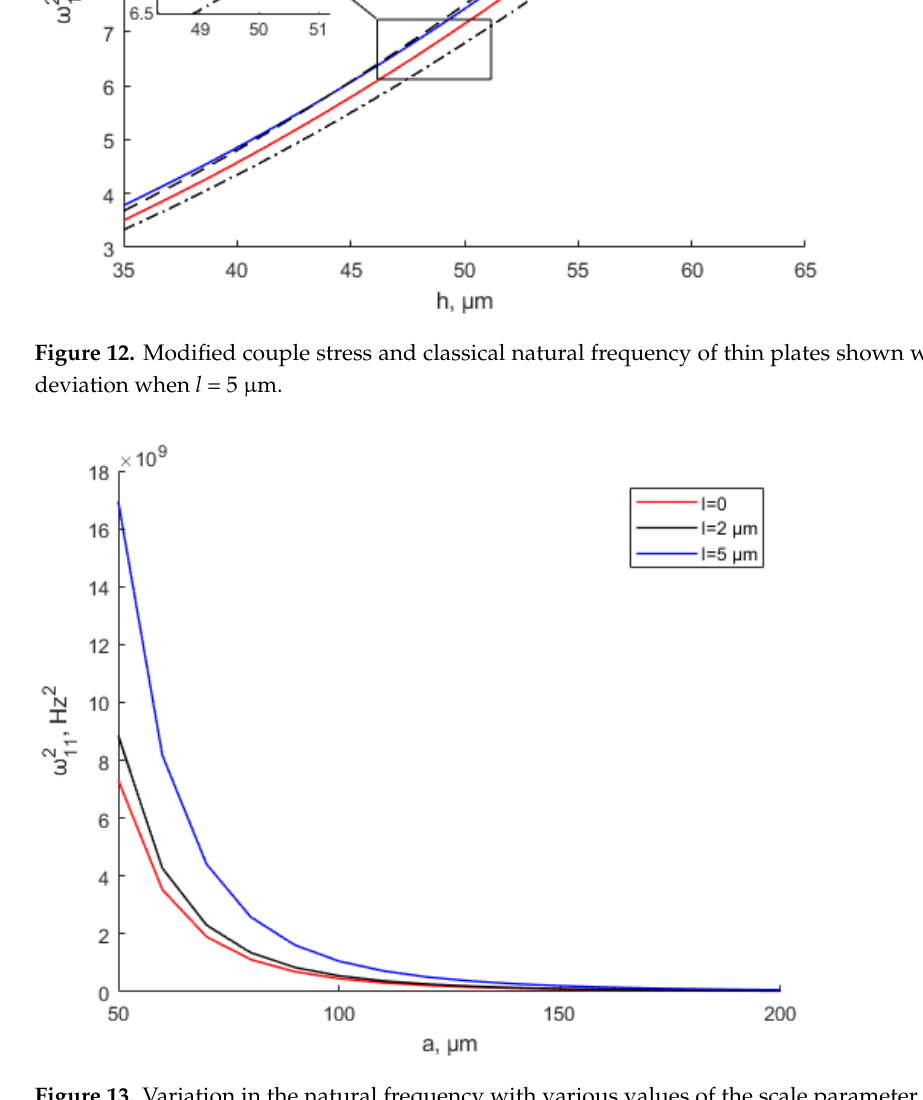
Figure 13. Variation in the natural frequency with various values of the scale parameter when h = 10 μ m.